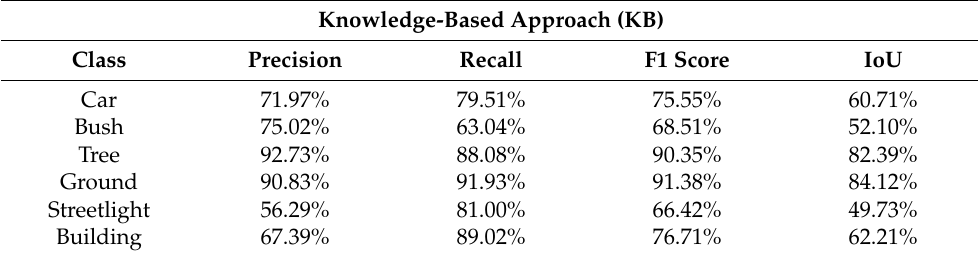
Table 2. Results of the statistics analysis of the knowledge-based (KB) approach.